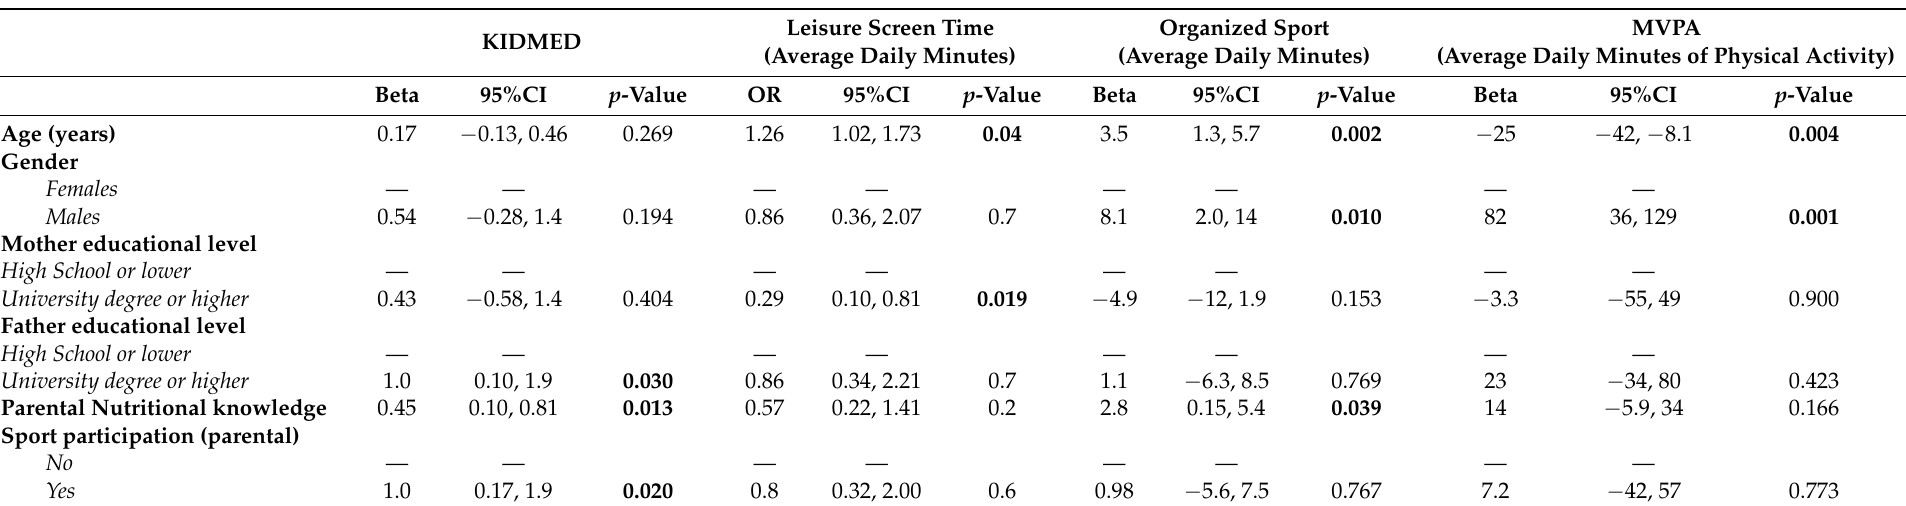
Table 2. Results of the Linear Regression